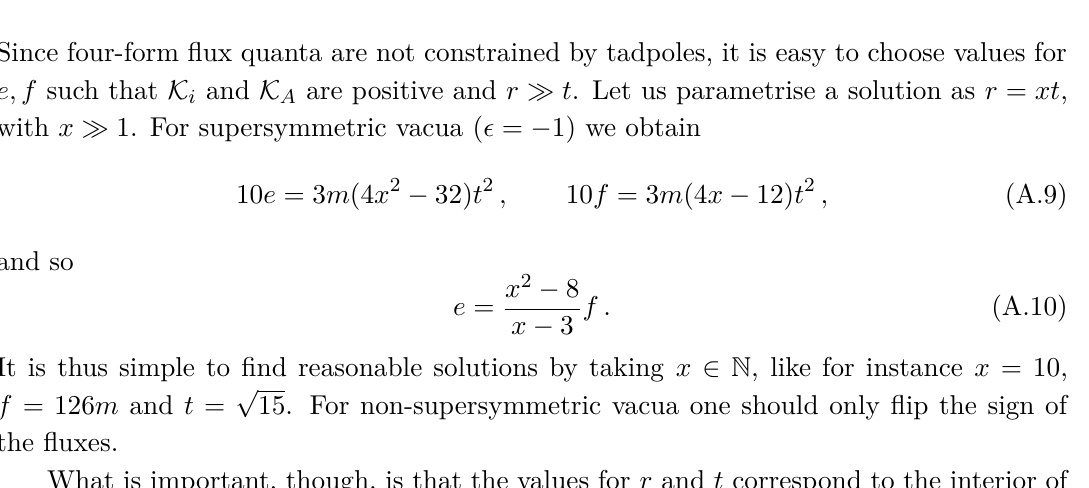
Table 6. Topological data of divisors on T 6 / ( Z 2 × Z 2 )